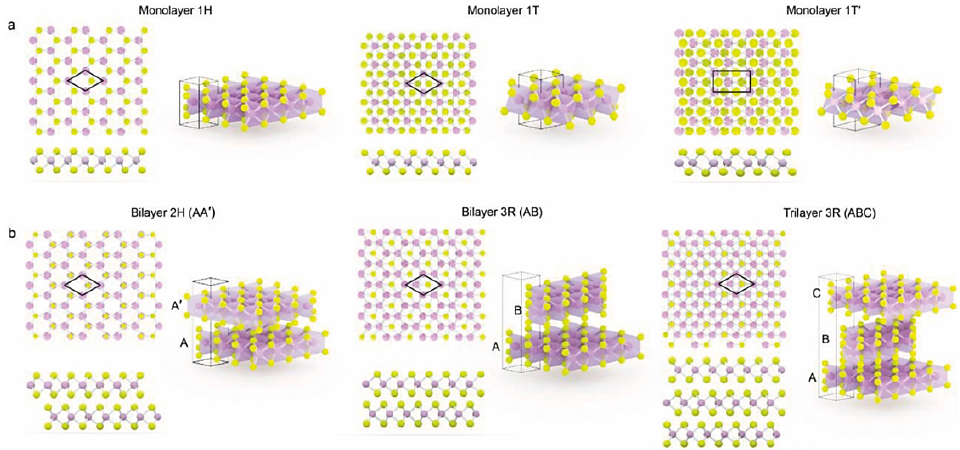
Figure 1. Atomic structures of various polymorphs of MoS 2 . ( a ) Monolayer structures; ( b ) bilayer and trilayer structures (yellow—S atoms; purple—Mo atoms). A, A’, B and C represent S-Mo-S layers. AA’, AB and ABC represent the stacking order sequence Reproduced from [44], with permission from John Wiley & Sons, Copyright 2018 Wiley–VCH GmbH.